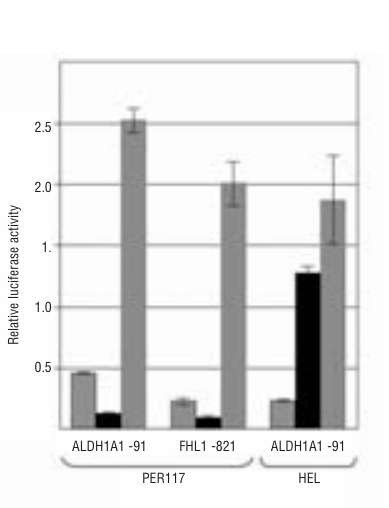
Figure 2. Activity of the human ALDH1A1 promoter and its differential regulation by TLX1. (A) ALDH1A1 pro- moter activity in the hematopoietic cell lines PER-117 and HEL. Luciferase activ- ity expressed as fold-change over the pro- moter-less pGL3-Basic vector after nor- malizing the luciferase signals to a β - galactosidase transfection control. The indicated ALDH1A1 promoter deletion constructs were transiently transfected into PER-117 cells (black bars) and HEL cells (gray bars). Deletion of the CCAAT box (-91 Δ CAT construct) abrogates pro- moter activity. The values represent the average of duplicate data points from three independent experiments. (B) The ALDH1A1 promoter is differentially reg- ulated by TLX1 in PER-117 and HEL cells. The indicated ALDH1A1 luciferase reporter constructs were co-electroporat- ed with a TLX1 expression plasmid and β -galactosidase expression plasmid into the cell lines PER-117 (black bars) and HEL cells (gray bars). Transactivation/ repression is shown as the fold-change (on a log2 scale) compared to back- ground levels obtained when an empty expression vector (no TLX1) was co-elec- troporated. Asterisks denote fold changes that were statistically different to zero ( p <0.05). The -91 Δ CAT construct har- bors a deletion of the CCAAT box. (C) Western blot confirming TLX1 protein expression in the transiently transfected PER-117 and HEL cells. U, untransfect- ed controls; T, TLX1 transfected. The faint band observed in the controls is non-specific.